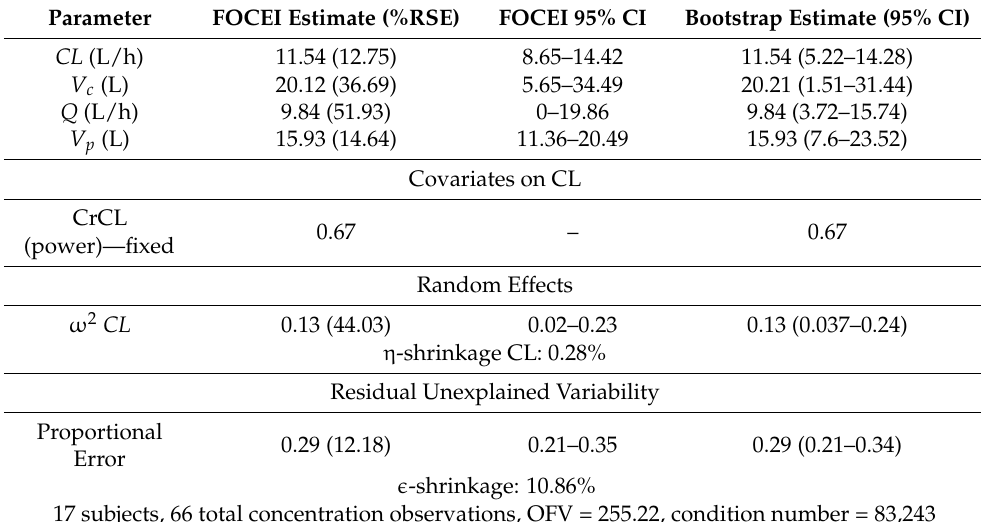
Table 3. Pharmacokinetic parameters for final tazobactam model.